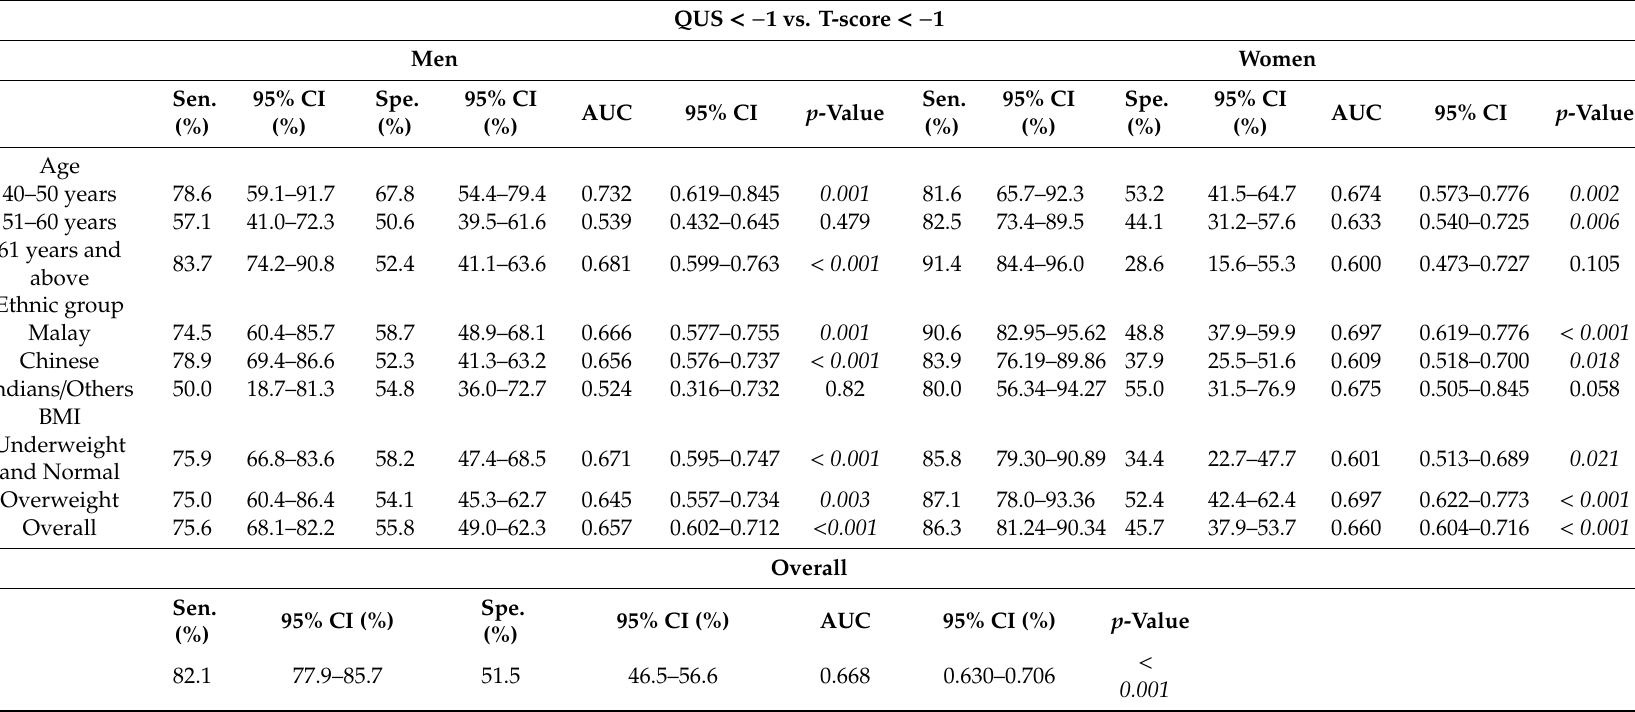
Table 3. The performance of CM-200 in identifying subjects with suboptimal bone health (DXA T-score < −